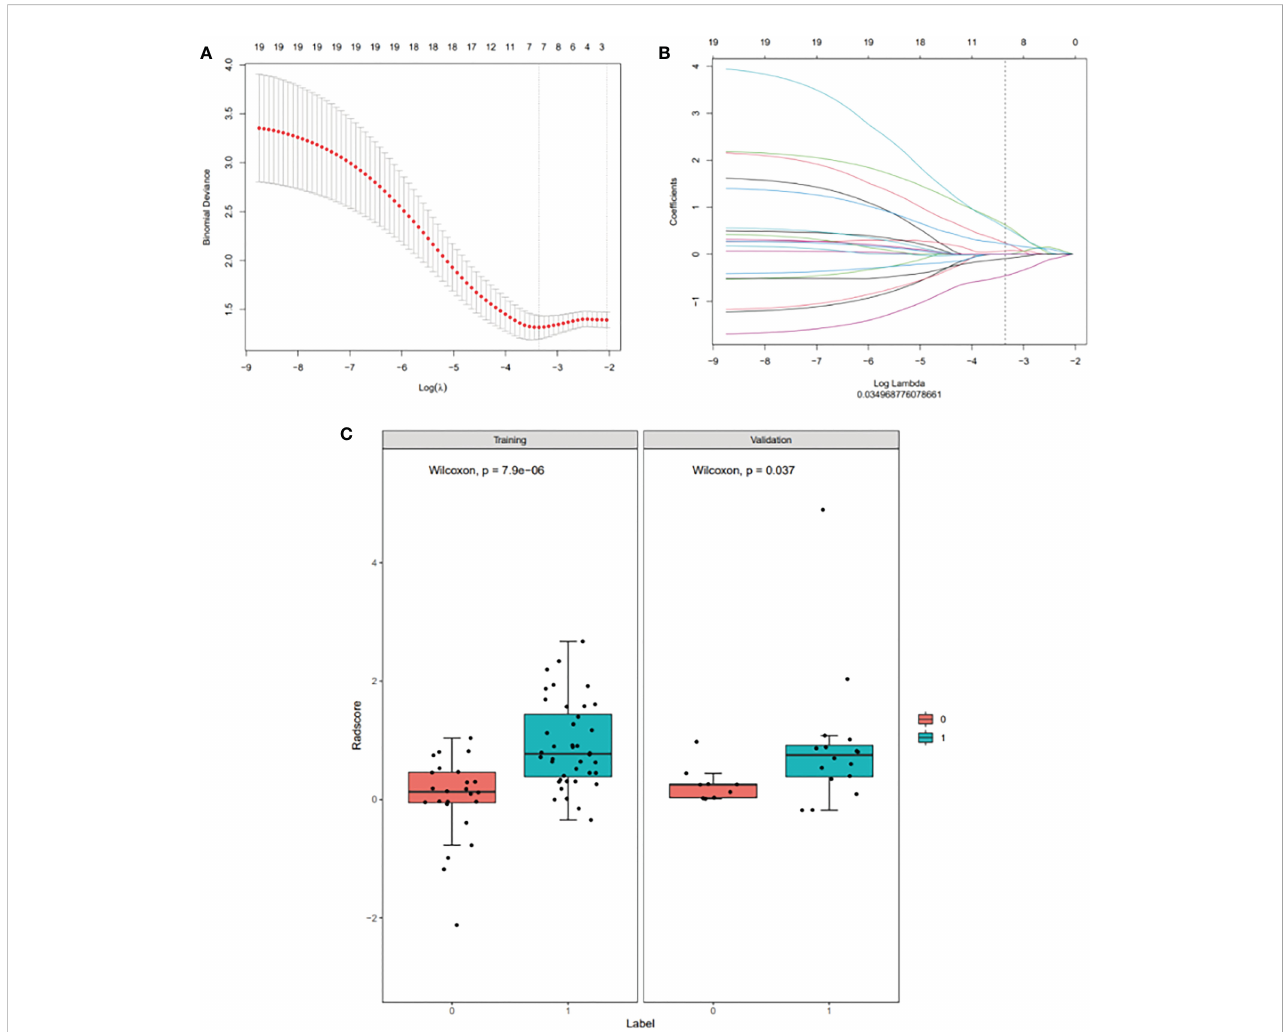
FIGURE 2 Radiomic feature selection using a least absolute shrinkage and selection operator (LASSO) binary logistic regression model (A, B) , with a comparison of the Rad-scores of the MPR and N-MPR groups (C) : Red represents the N-MPR group and blue represents the MPR group. There was a signi fi cant difference in Rad-score between MPR and N-MPR patients in the training (P<0.001) and validation cohorts (P = 0.037). (A) Selection of the tuning parameter ( l ) for the LASSO model via 10-fold cross-validation based on minimum criteria. The y-axis indicates binomial deviance. The lower x-axis indicates the log ( l ). Numbers along the upper x-axis represent the average number of predictors. The optimal l value of 0.035 with log ( l )= - 3.353 was selected. (B) LASSO coef fi cient pro fi les (y-axis) of the 20 texture features. The upper and lower x-axis has the same meaning as in Fig. 2A. A black vertical line was drawn at the value selected using 10-fold cross-validation in Fig. 2A. The 7 resulting features with non-zero coef fi cients are shown in the plot. (C) Comparison of Rad-scores between the MPR and N-MPR groups. Red represents the N-MPR group and blue represents the MPR group. There was a signi fi cant difference in the Rad-scores of MPR and N-MPR patients in both the training (P<0.001) and validation cohorts (P =